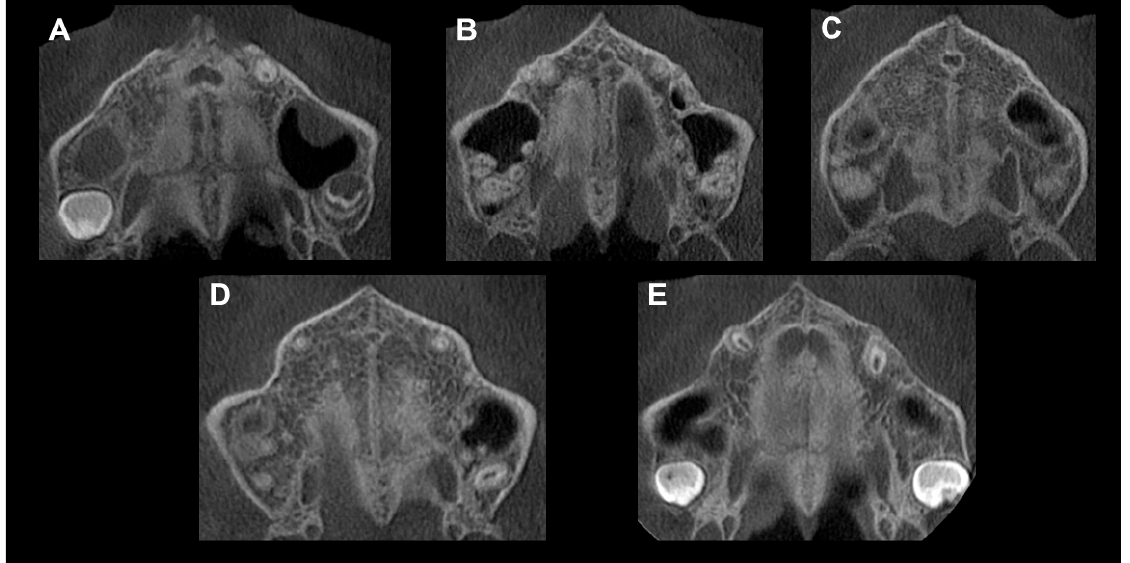
Figure 3. Method of Angelieri et al. [40] in CBCT. ( A ) The midpalatal suture is seen as a relatively straight radiopaque line. ( B ) The midpalatal suture appears as a scalloped line of high density. ( C ) Two radiopaque, scalloped and parallel lines are separated by areas of low radiographic density. ( D ) The palatine bones become more radiopaque, and the suture is not visualized in this sector; it is only visualized as two scalloped high-density lines at the midline on the palate bone. ( E ) It is no longer possible to see the suture along the maxillary and palatine bones, which indicates that fusion has occurred in the maxilla.